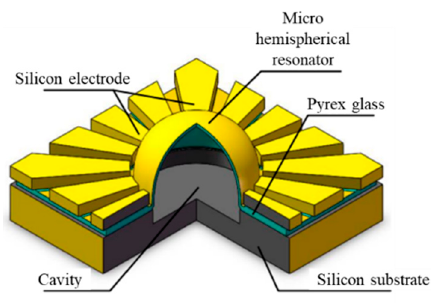
Figure 1. µ HR structure Figure 1. μ HR structure illustration.